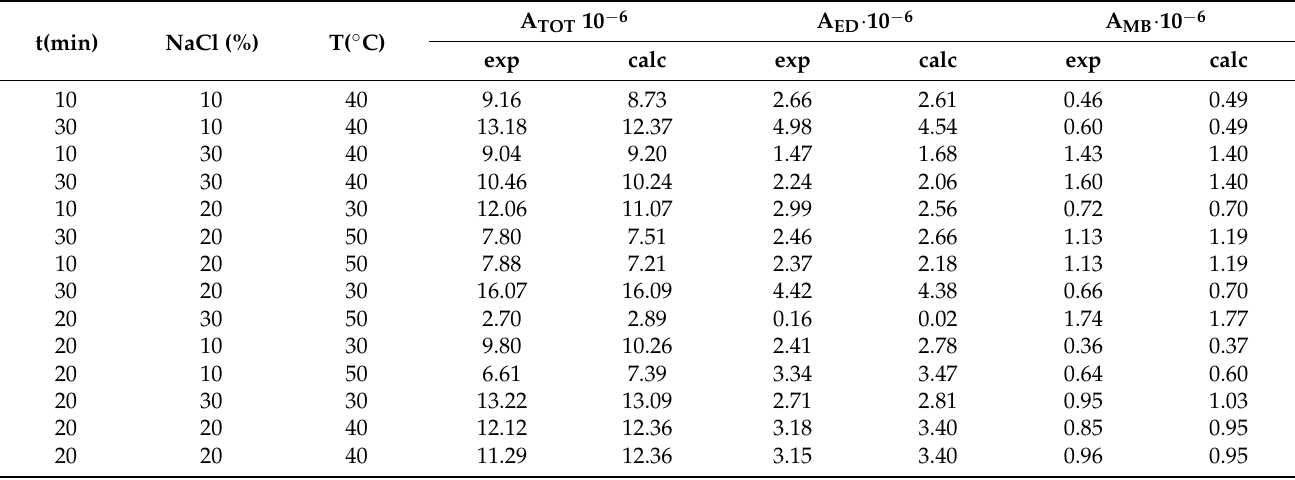
Table 2. Points of the Box-Behnken DoE adopted to investigate SPME efficiency of the PDMS fiber with experimental (exp) and calculated (calc) values of the responses: total area of the GC chromatogram (A TOT ), peak areas of ethyl decanoate (A ED ), and 3-methyl-1-butanol (A MB